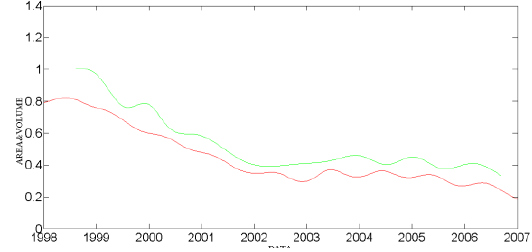
Fig. 7. Water volume change (Green), water level change